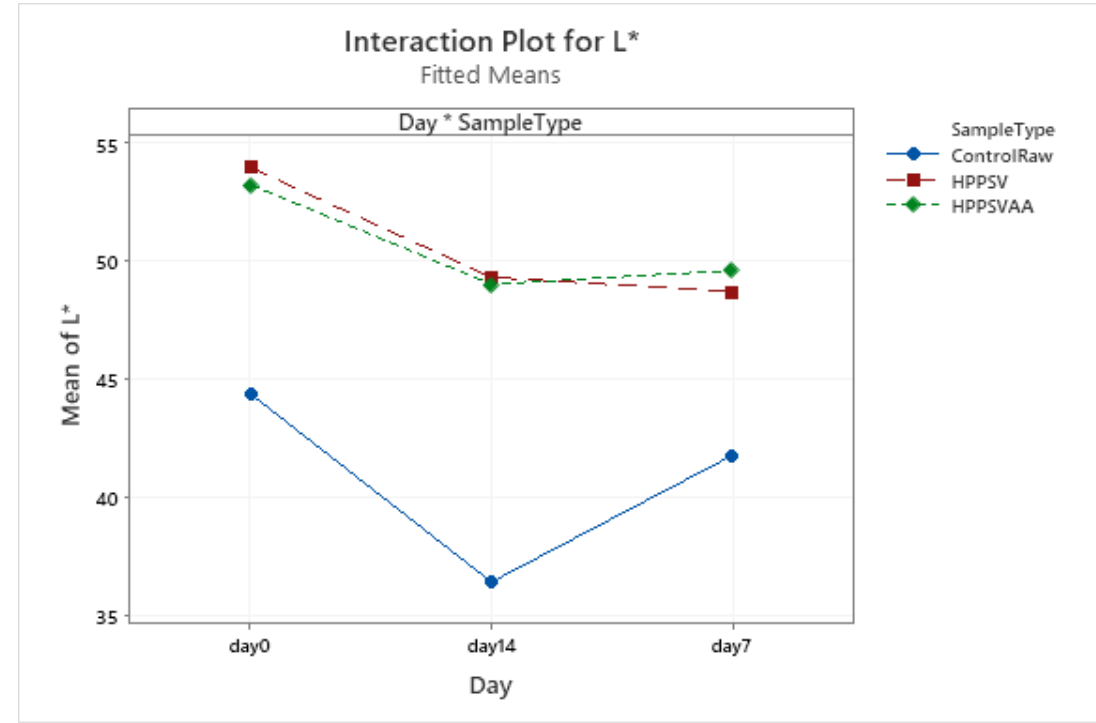
Figure A12. Effect of treatments and storage time on the chewiness of hybrid patty (HPPSV: HPP- SVCOOK).